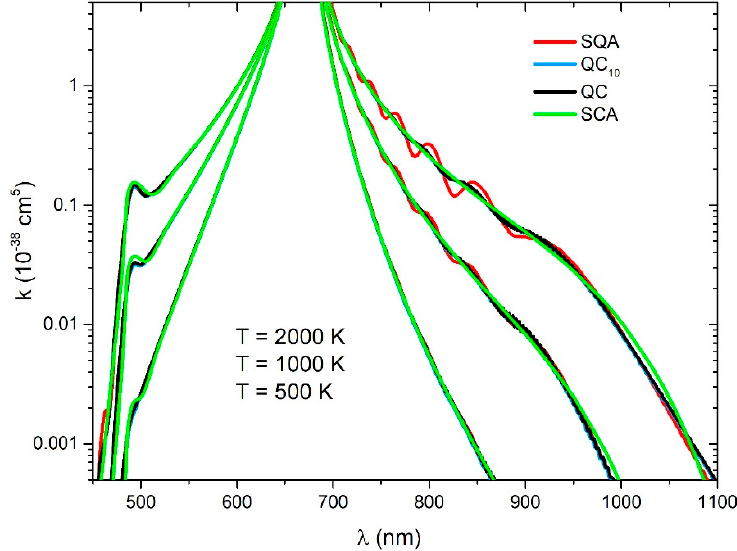
Figure 3. Li − He reduced absorption coefficient for the B 2 Σ → X 2 Σ ( left ) and A 2 Σ → X 2 Σ transitions ( right ) for three different temperatures (2000 K, 1000 K, 500 K), obtained with four theoretical approaches (SQA, QC 10 , QC, SCA).